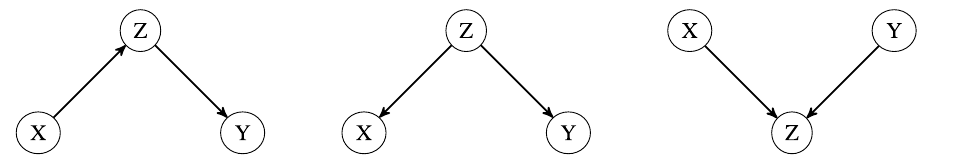
Figure 1. Left: causal chain, middle: fork or common effect, right: v − structure; from three variables X , Y , Z